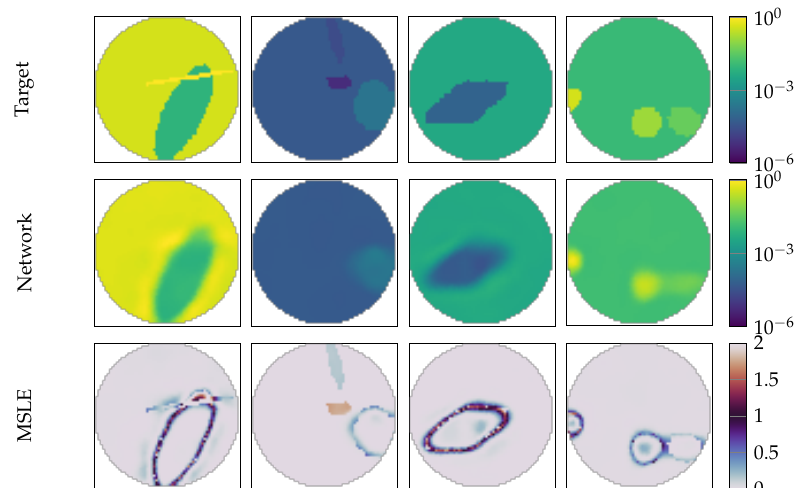
Figure 5. Illustration of RF-REIM-NET reconstructions on the validation dataset. At the top, the original targets are given. In the middle, the reconstructions of RF-REIM-NET are presented. At the bottom, the MSLE error between the original image and the reconstruction are